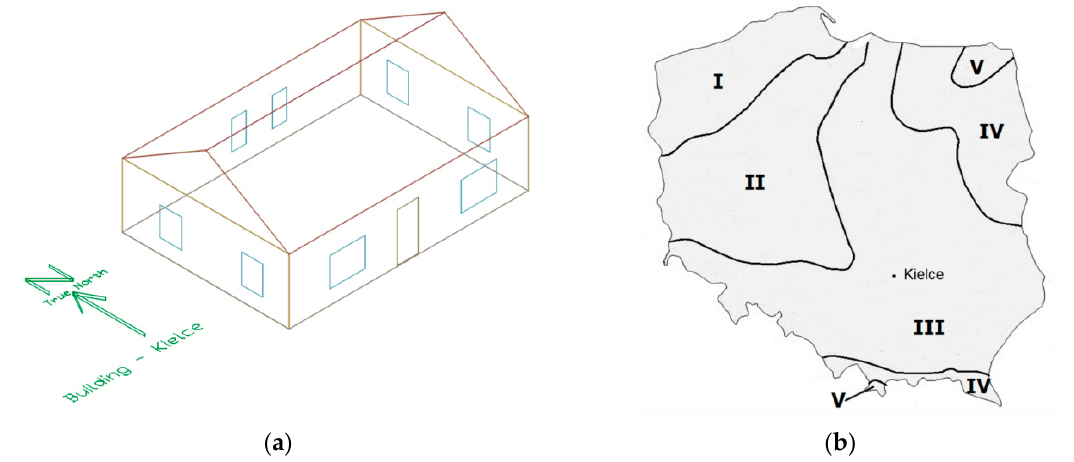
Figure 2. ( a ) Three-dimensional model of the test building in EnergyPlus; ( b ) location of the building.